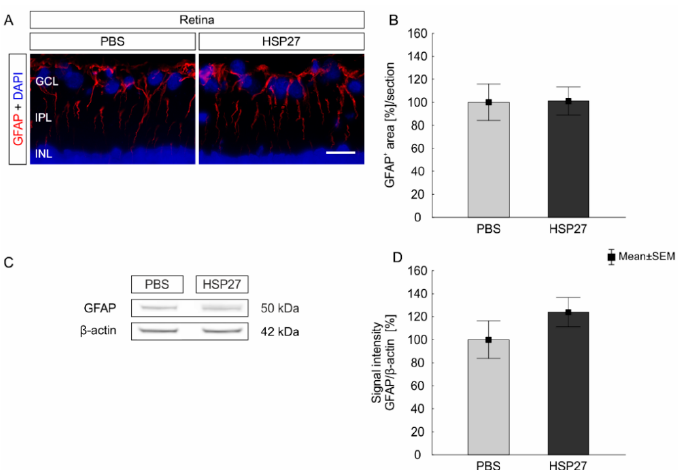
Figure 6. No macroglia cell response after HSP27 injection. ( A ) Macroglia (GFAP, red) and cell nuclei (DAPI, blue) were stained in the retina. ( B ) After 21 days, the GFAP + area of the HSP27 group was similar to the one in the PBS group ( p = 0.83). ( C ) GFAP (50 kDa) protein level was measured with western blot and normalized with β -actin (42 kDa). ( D ) Again, no significant differences were found between the two groups ( p = 0.27). GCL = ganglion cell layer, IPL = inner plexiform layer, INL = inner nuclear layer, scale bar = 20 μ m, n = 6/group (immunohistology and western blot). 2.4. No Demyelination, but Neurofilament Damage of Optic Nerves, after 21 Days Myelin sheaths of optic nerves were stained with luxol fast blue (LFB) 21 days after the intravitreal injection (Figure 7A). No differences between the PBS group (0.7 ± 0.2 mean score) and HSP27 group (0.9 ± 0.1 mean score, p = 0.21) could be detected regarding the LFB score (Figure 7B). Hence, HSP27 likely had no damaging effect on the myelin sheaths of the optic nerves.